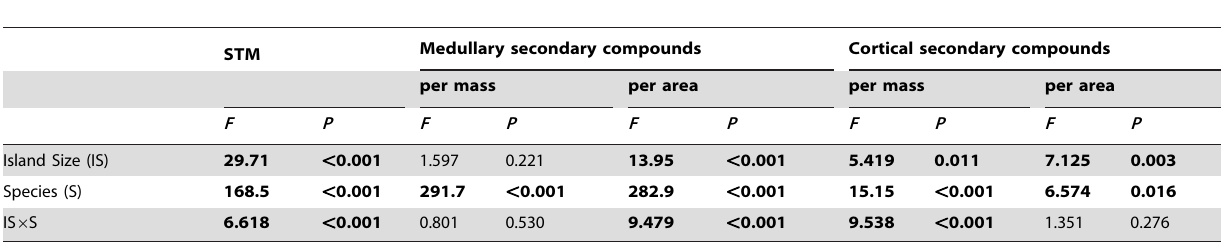
Table 1. ANOVA results for island size and species effects on lichen traits.